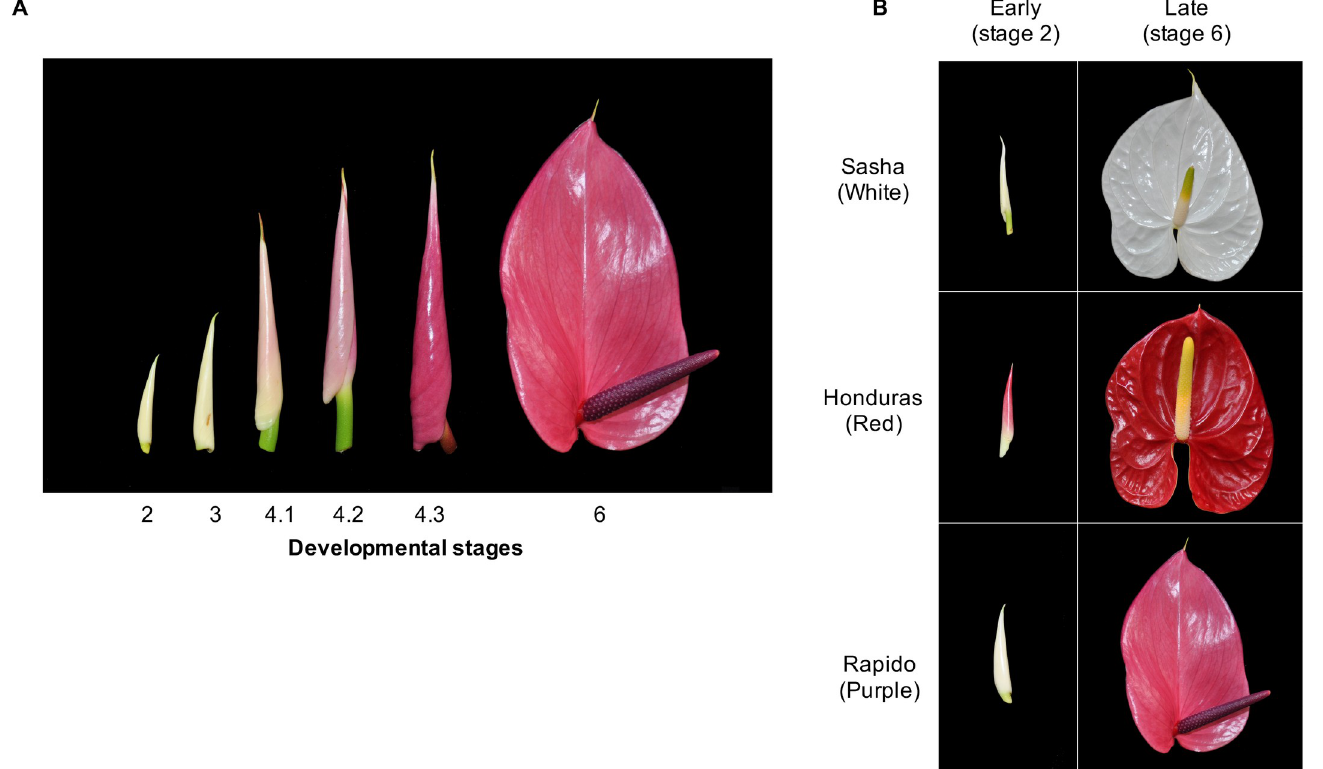
Fig 1. Cultivars and stages of Anthurium andreaeanum used in the present study. (A) Stages of spathe development for Anthurium andraeanum . (B) Stages 2 and 6 used for each of the three cultivars for the RNA-seq assay.